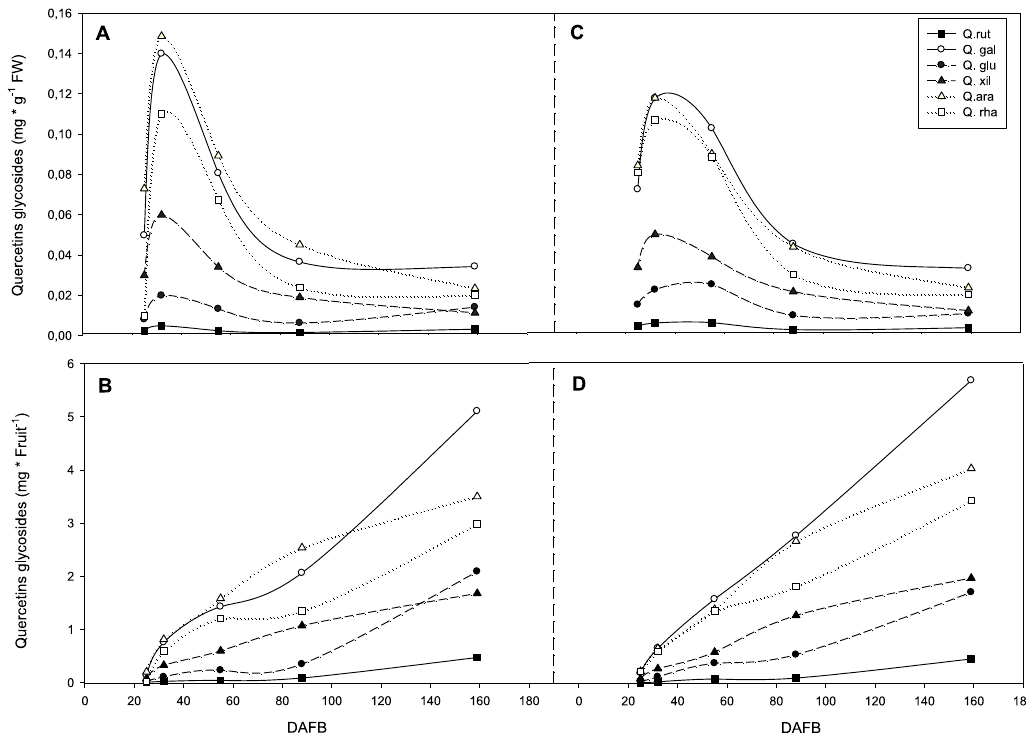
Fig. 1: Evolution of quercetins glycosides concentration and content in whole fruit from apple cv. Granny Smith, from conventional (A and B) and organic (C and D) orchards, in different stages of development, during 2009/2010 season. Curves end at harvest. Q.rut, rutinoside; Q.gal, galactoside; Q.glu, glucoside; Q.xil, xyloside; Q.ara, arabinoside; Q.rha,